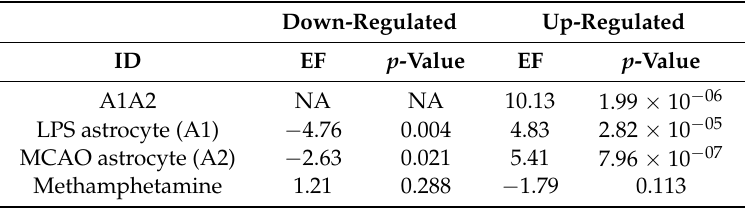
Table 7. Signature analysis of several signatures of activated astrocytes.